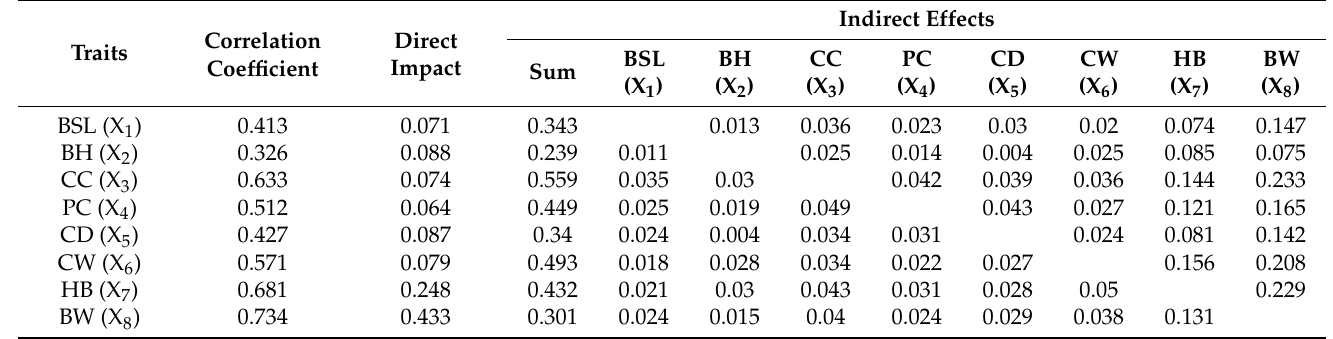
Table 3. Path coefficient analysis between body measurements, body weight, and cashmere yield of Liaoning cashmere